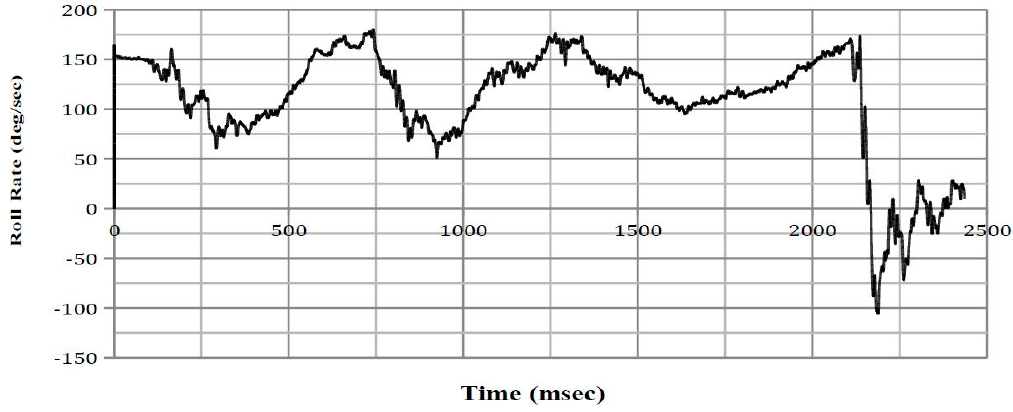
Figure A1. Vehicle centre of gravity lateral velocity (relative to the global x-axis).